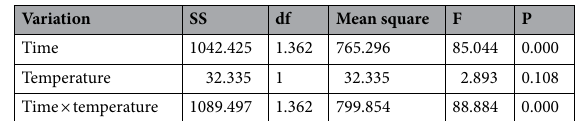
Table 8. Analysis of variance of GABA repeated